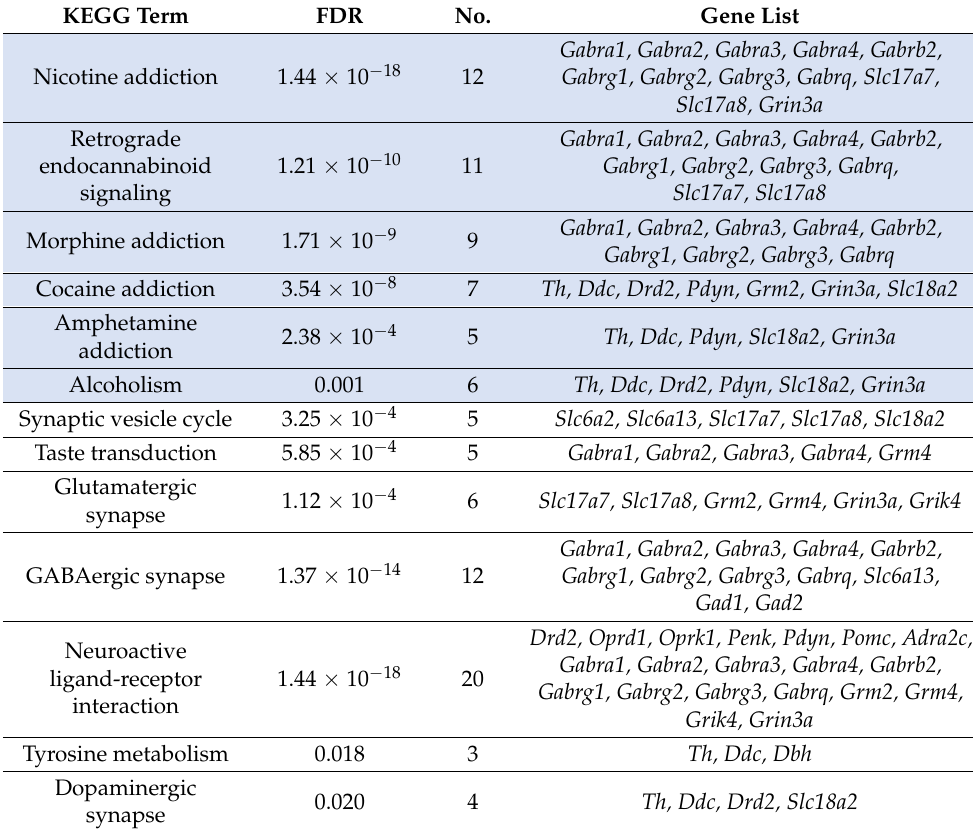
Blue color: genes that are directly involved in drug addiction processes. FDR: false discovery